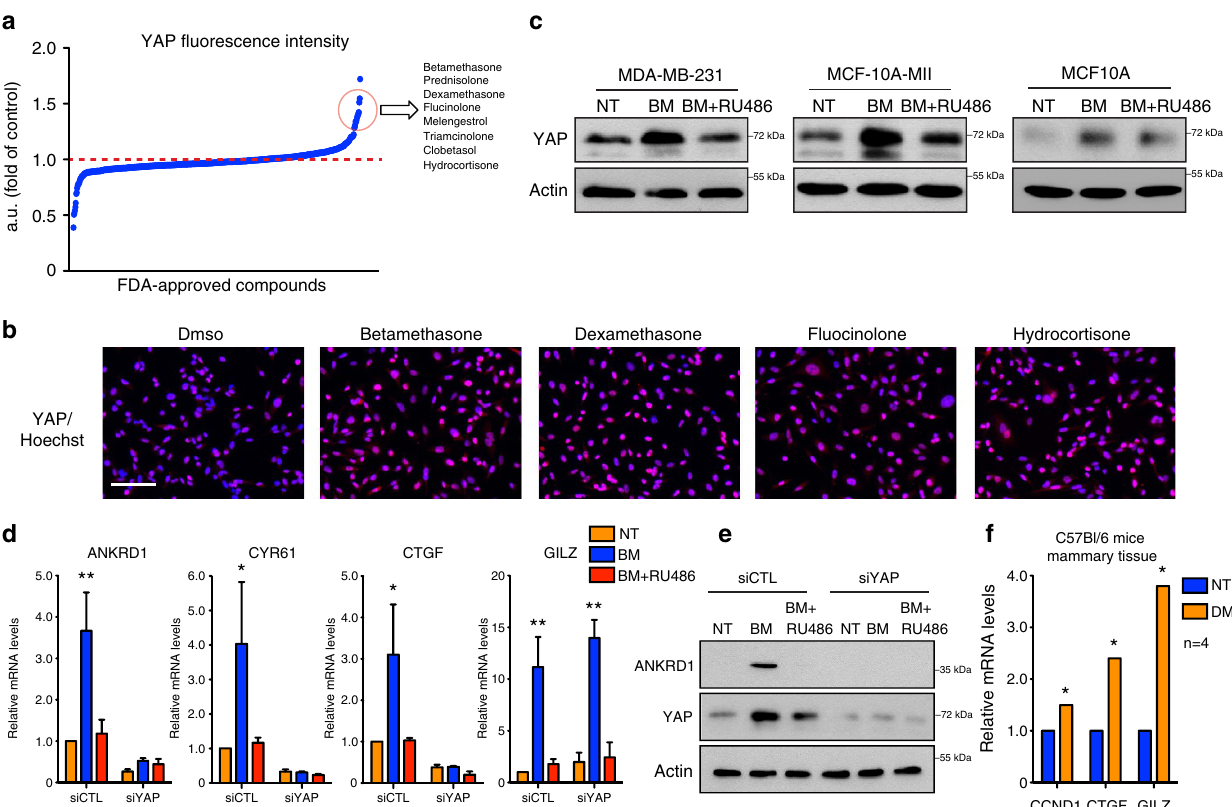
Figure 1 | Glucocorticoids induce activation of the Hippo transducer YAP in vitro and in vivo . ( a ) Results of the high-content screening. YAP fluorescence intensity is relative to DMSO-treated samples. ( b ) Representative images from the screening. MDA-MB-231 stained for Hoechst (blue) and YAP (red) after treatment with DMSO or the indicated glucocorticoids are shown. Experiment repeated two times. Scale bars, 100 m m. ( c ) MDA-MB-231, MCF10A and MII cells were treated with BM 1 m M alone or in combination with RU486 1 m M for 24h. Representative blots are shown. Experiment repeated three times. ( d ) Quantitative PCR with reverse transcription (qRT–PCR) analysis of MDA-MB-231 transfected with indicated siRNA for 48h and treated with 1 m M BM alone or in combination with RU486 1 m M for 24h. siCTL is control siRNA. Error bars represent mean ± s.d., from n ¼ 3 biological replicates. siYAP sequence is siYAP#1. ( e ) MDA-MB-231 cells were treated as in d , representative blots are shown. Experiment repeated three times. siYAP sequence is siYAP#1. ( f ) qRT–PCR analysis of breast epithelial tissue from control (NT) or dexamethasone (DM)-treated mice. Error bars represent mean ± s.d., n ¼ 4 mice per group. * P o 0.05, ** P o 0.01; two-tailed Student’s t -test is used